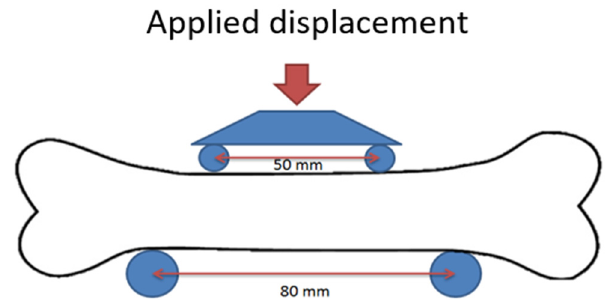
Figure 2. The setup of the four-point bending test. The defect is created at the compressed site of the bone, which was the anterior side of the radius.